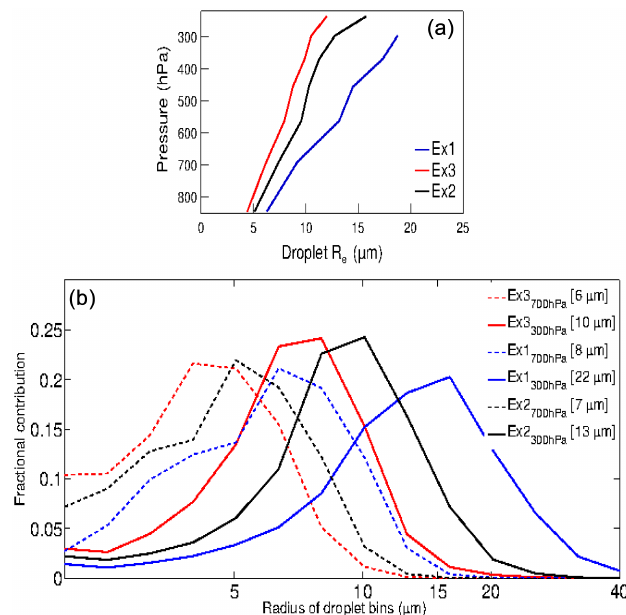
Figure 7. (a) Mean droplet R e versus CTP for low- (Ex1; blue), medium- (Ex2; black), and high- (Ex3; red) CCN scenario. (b) Droplet size distribution spectra of Ex1 (blue), Ex2 (black), and Ex3 (red) simulations at 700hPa (dashed lines) and 300hPa (solid lines). The corresponding effective radius values are mentioned in the legends in square brackets. The fractional contribution is calcu- lated by dividing the mass concentration of each bin with the total mass concentration.